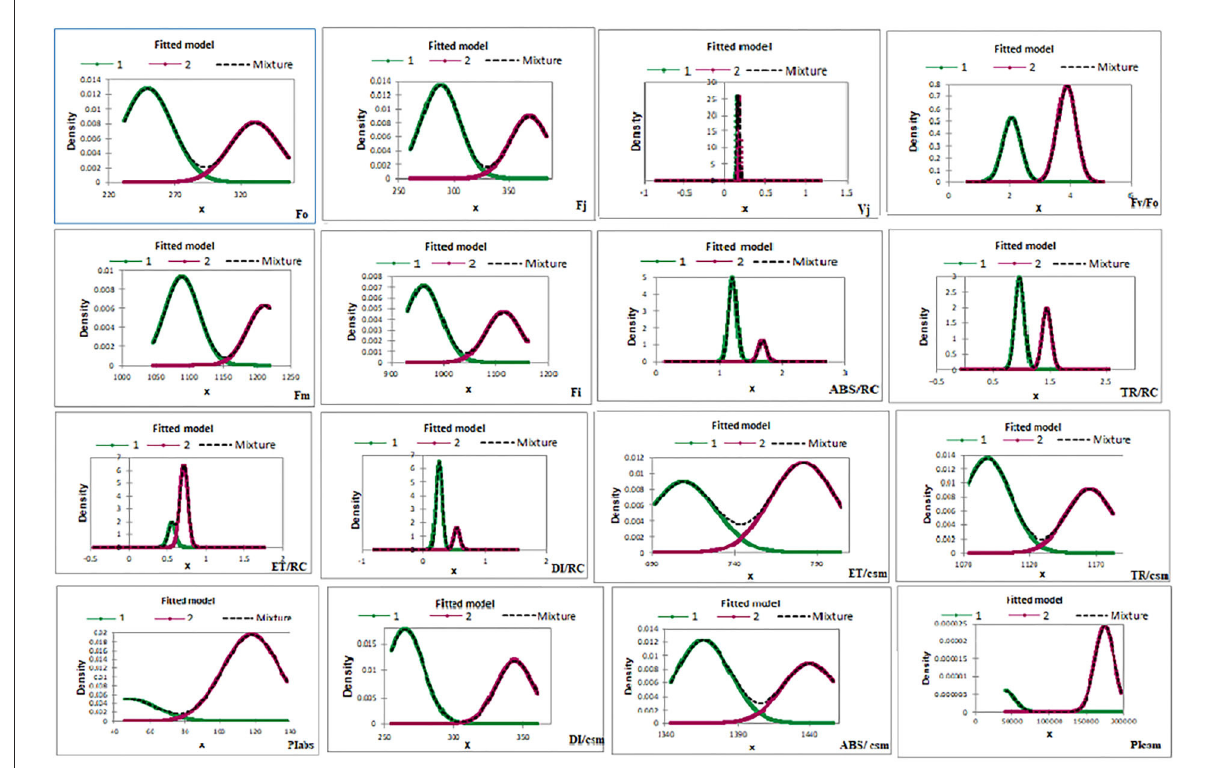
FIGURE11 Energy-fitted model of G-mean clustering of different chlorophyll fluorescence